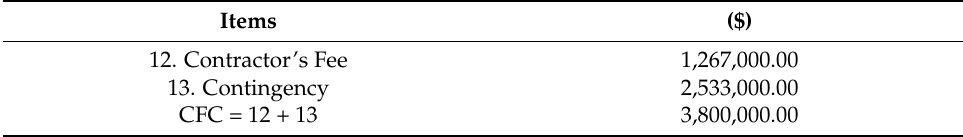
Table 3. Contractor’s Fee & Contingency (CFC).